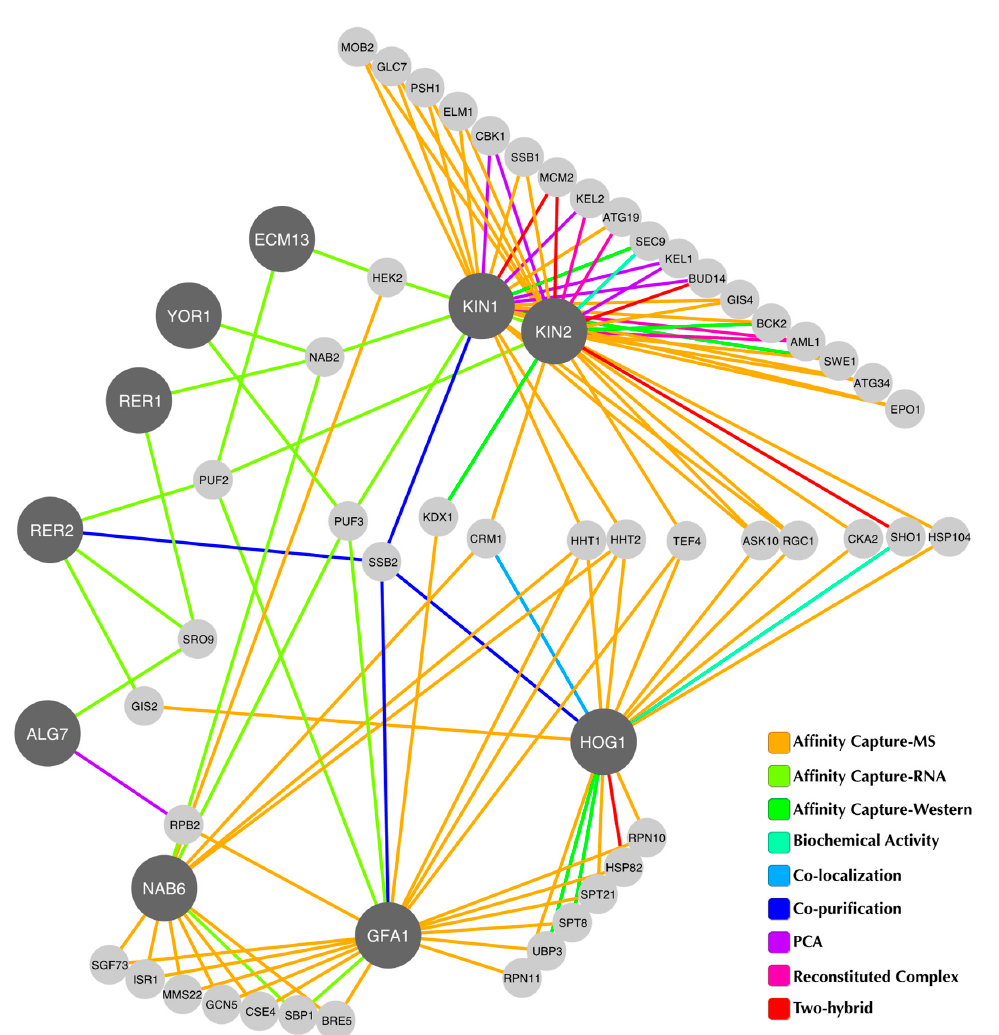
Figure 5. Physical interaction network. Physical interactions of suppressor proteins and Hog1 as deduced from the BioGRID database and visualised with Cytoscape. The network was constructed according to the criteria described in the methods section. Hog1 and suppressor proteins are depicted with dark grey circles. The connecting lines represent the physical interactions and are colored according to the experimental assay that supports each interaction. Known interactors found in the database are colored in light grey.